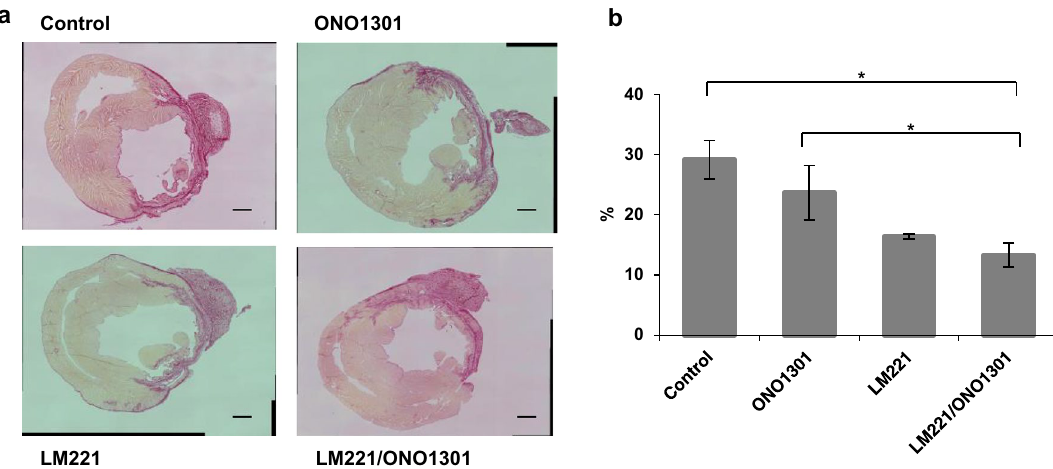
Figure 7. The combined administration of LM221 and ONO1301 reduced fibrosis. Fibrosis was observed by Picro-Sirius Red staining. ( a ) Representative microscopic images of the infarct size. Scale bars = 1000 μm. ( b ) The graph indicates the size of fibrosis at the implanted site 4 weeks after surgery. * p < 0.05.